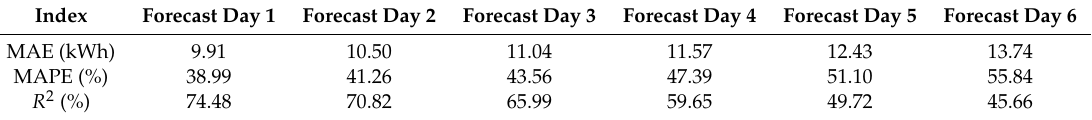
Table 1. Error metrics for the point load forecast. Comparison between forecast and real heating